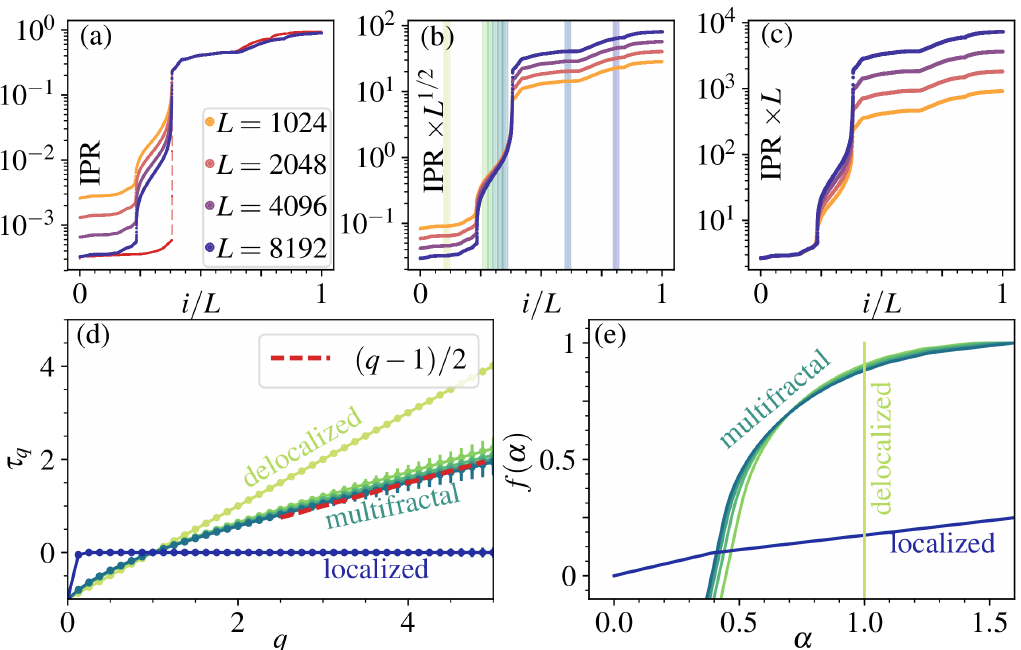
Figure 2: Characterisation of Floquet multifractal states. (a)-(c) The inverse participation ratio (IPR), shown for the Floquet eigenstates sorted in increasing order of I , for different 2 system sizes L . The collapse of different segments of the data for different L , when the IPR is scaled with (a) L 0 , (b) L 1 / 2 , and (c) L reflects the presence of localised, multifractal, delocalised states, respectively. The data in red in (a) shows the IPRs of static eigenstates (for L = 8192) for reference. (d) Averaging the moments over Floquet eigenstates in different windows high- lighted by the vertical shaded regions in (b), τ is plotted as a function of q , where the colour q corresponds to the window. While the localised (blue) and delocalised (yellow) states show ≈ D ( q − 1 ) the expected standard behaviour, the multifractal states (shades of green) have τ q at q (cid:166) 1 with D (cid:39) 1 / 2 (red dashed line). When averaged over all the multifractal states, the = 0.55 ± 0.04 close to D (cid:39) 1 / 2. The τ IPRs scale as L − τ 2 , where τ s are extracted as the q 2 slope of a linear fit of log I versus log L . Representative fits are shown in Fig. 3. (e) The corre- q sponding spectrum of fractal dimensions, f ( α ) as function of α clearly shows the multifractal = 2 J , states distinct from both localised and delocalised cases. The system parameters are V 0 ∆ V = J / 2, and Ω = 2.74 π J , where the bandwidth of the undriven spectrum is ≈ 2.76 π J (see Appendix B for effects of lower